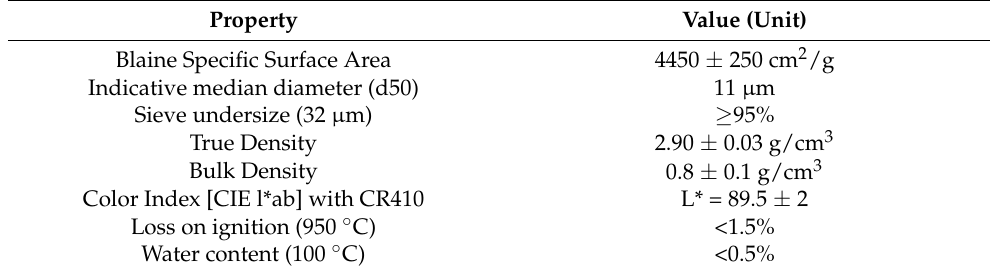
Table 2. GGBS Technical Data [23].